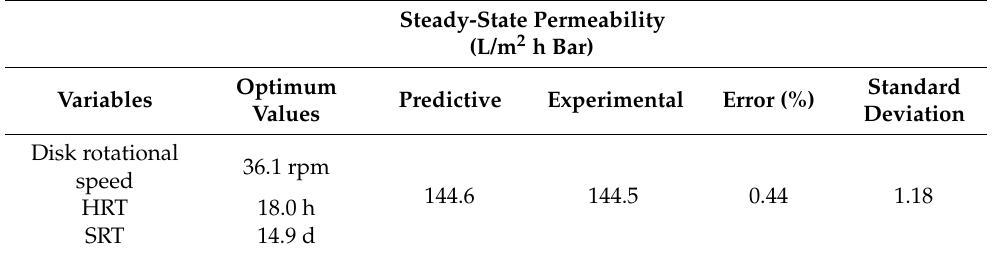
Table 7. Optimized operational parameter values at maximum steady-state membrane permeability.